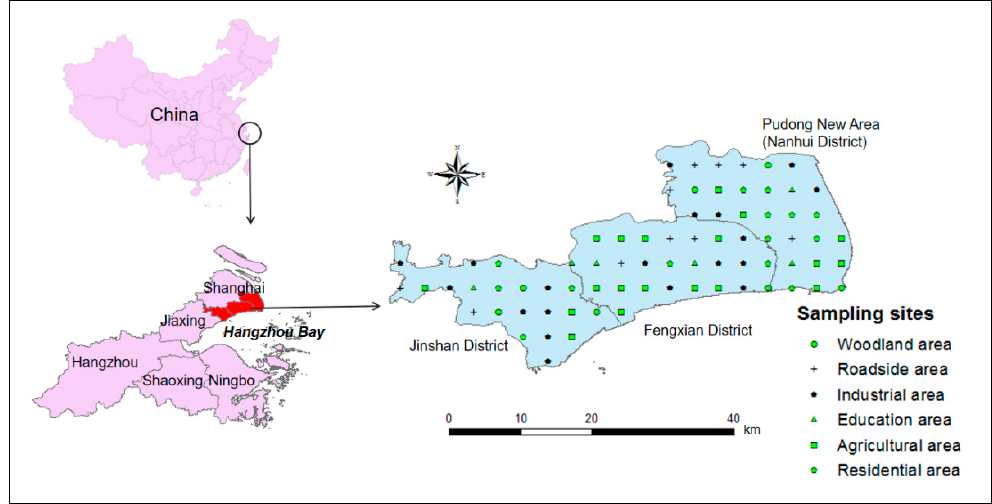
Figure 1. A map of the soil sampling sites and study area in Shanghai.